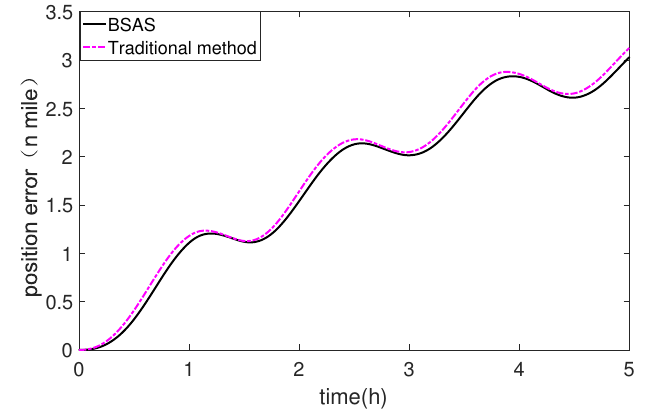
Figure 10. Error of latitude and longitude.